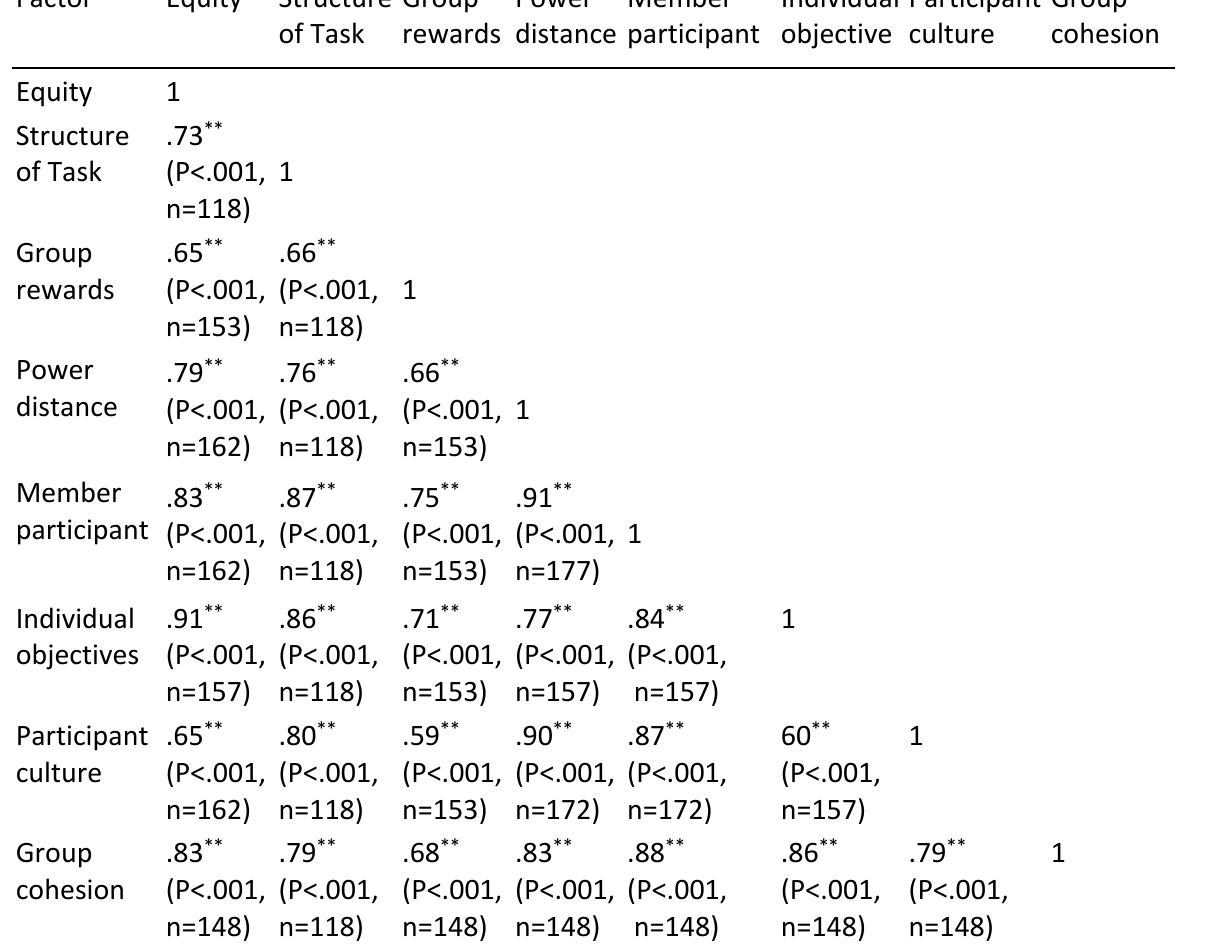
Correlation Coefficient of the